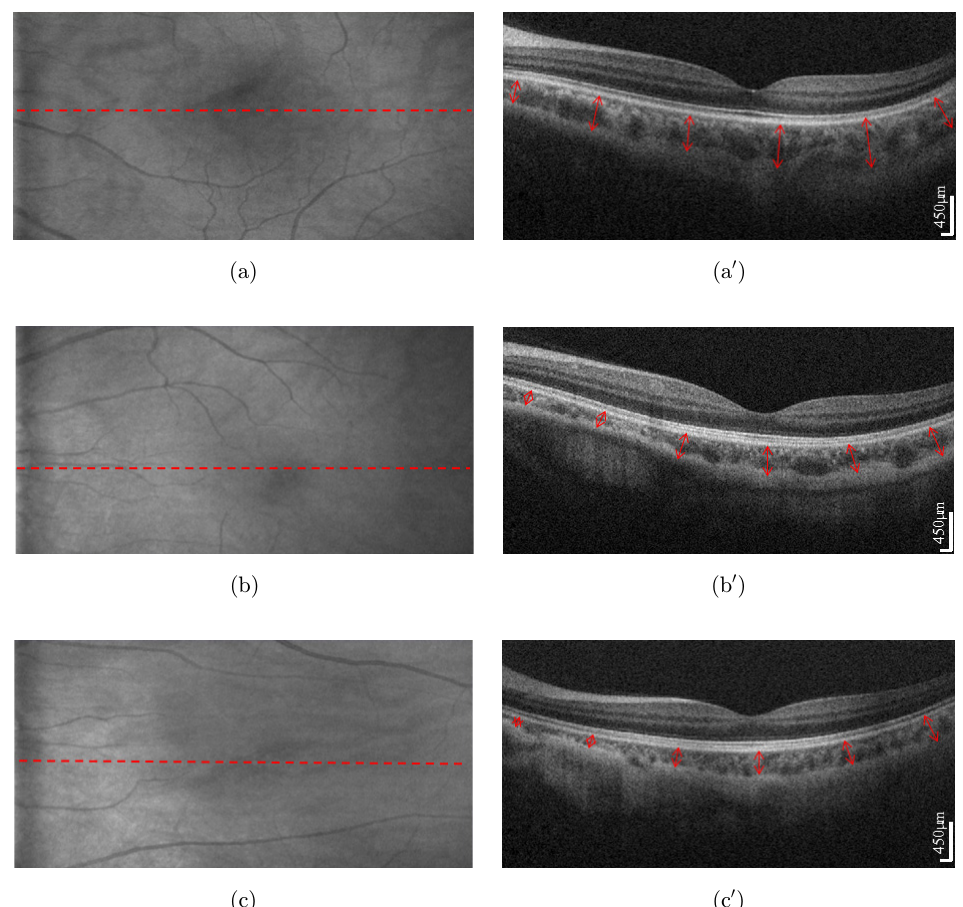
Fig. 3. The CT of myopic eyes. (a), (b) and (c) is the projection of the low ( (cid:2) 1D), moderate ( (cid:2) 5D) and high myopic ( (cid:2) 8D) eye, respectively. The choroid is shown on the cross section SDOCT scan (a 0 ) (b 0 ) and (c 0 ). The CT is measured vertically from the outer border of the RPE to the outer border of the choroid (shown with red arrow).